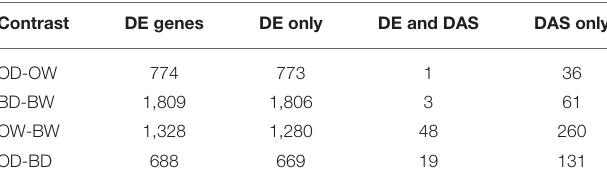
TABLE 1 | Number of genes that are regulated by differential expression and/or by differential alternative splicing (DAS) in the different contrast groups.